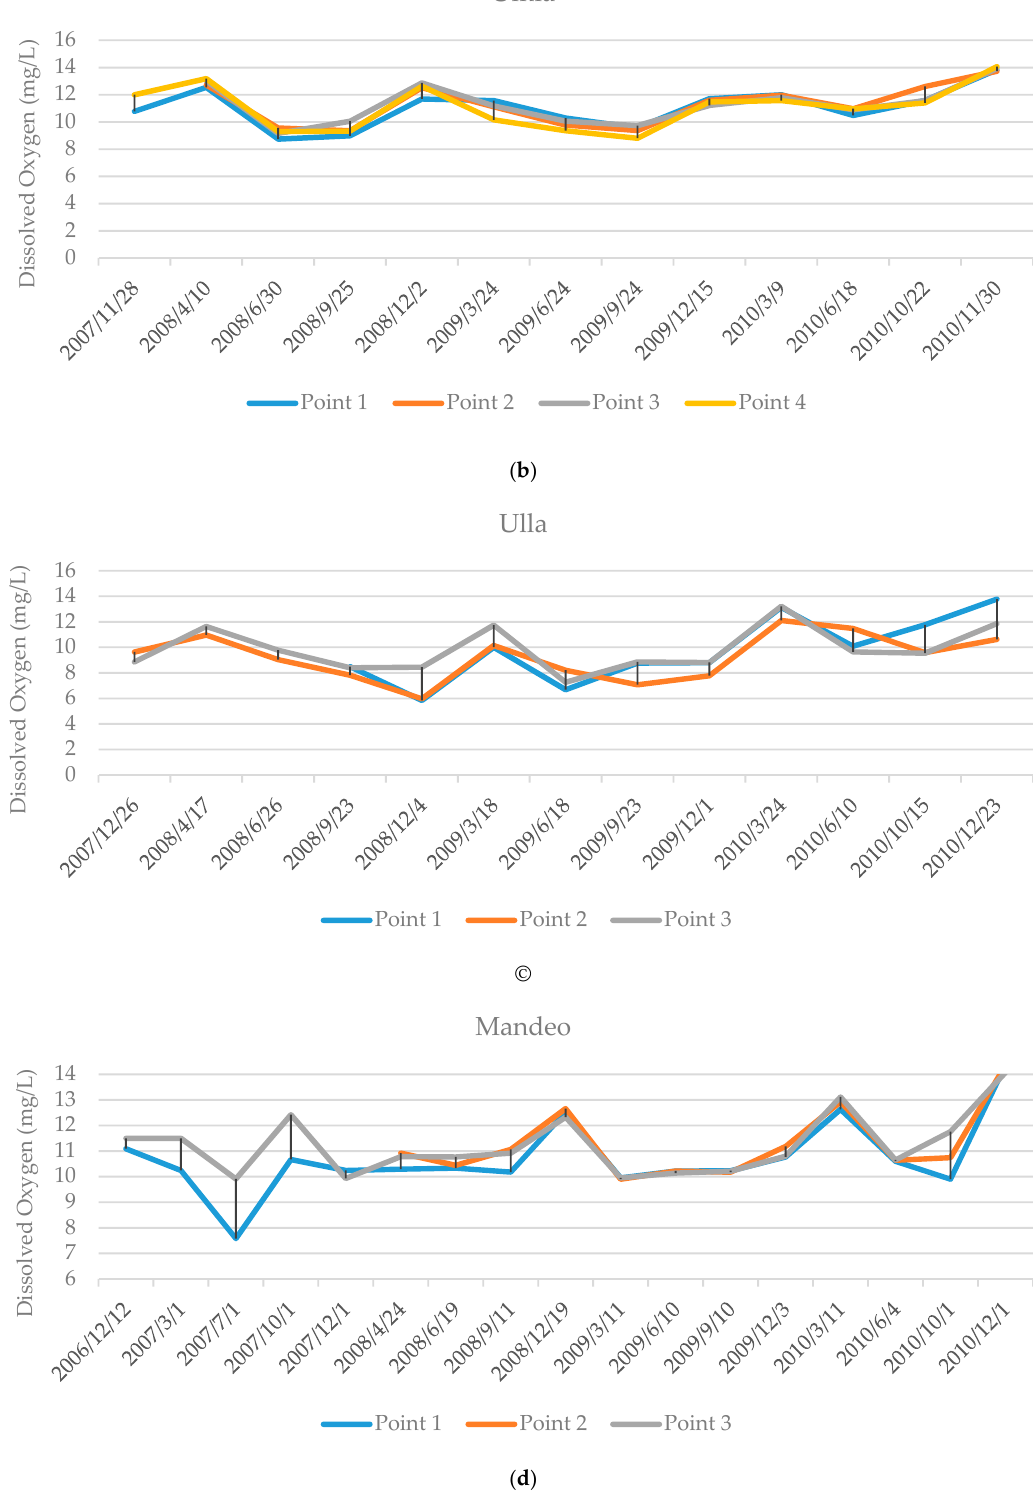
Figure 5. Dissolved oxygen values measured during the survey period at ( a ) Lerez (San Xusto plant), ( b ) Umia (Hermida plant), ( c ) Ulla (Touro plant) and ( d ) Mandeo (Gomil plant).